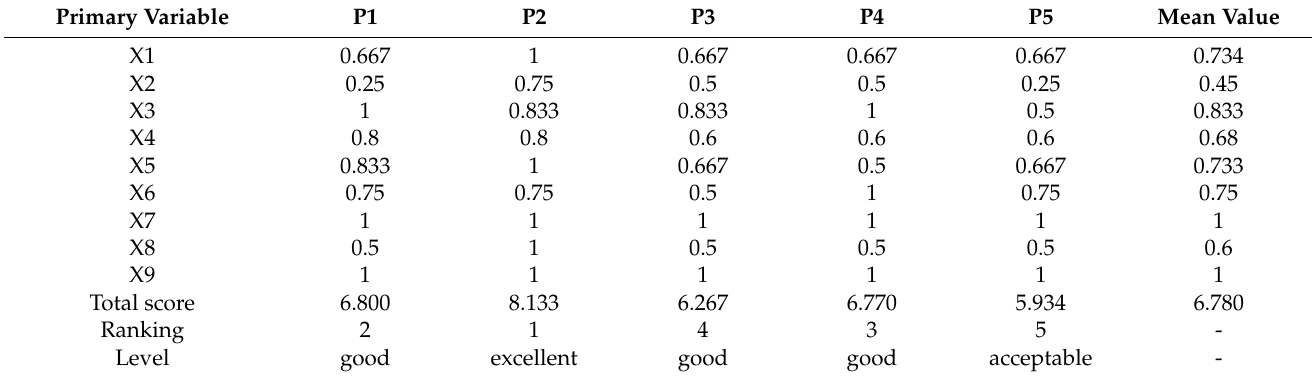
Table 8. Summary of PMC index of five pig price control